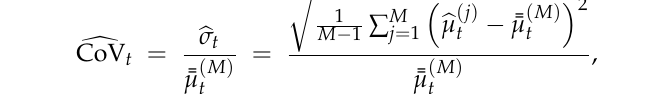
Figure 4. Out-of-sample losses of nagging predictors ¯¯ µ